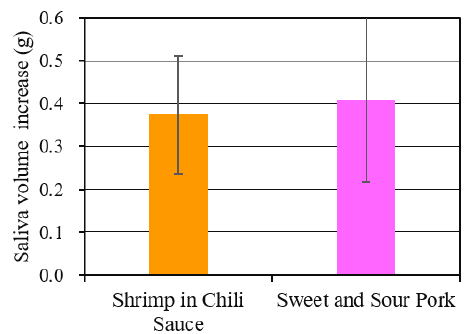
Figure 6. Changes in saliva volume after viewing contents in STUDY 1.